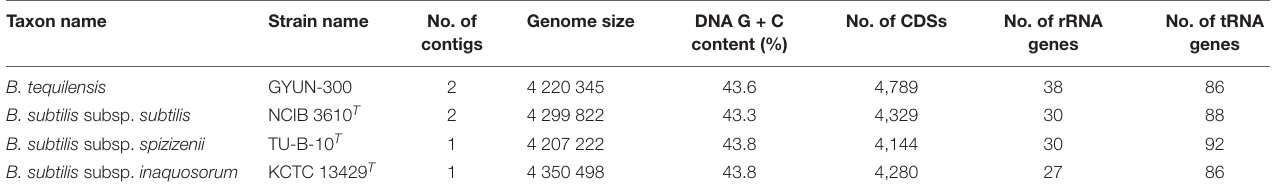
TABLE 1 | Genomic features of the Bacillus tequilensis GYUN-300 genome and comparison with genomes of other Bacillus subsp. belonging to the Bacillus subtilis